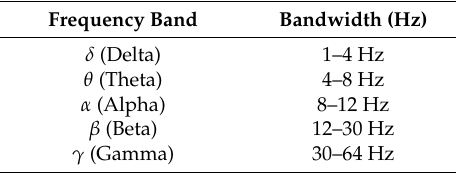
Table 3. Frequency band ranges of EEG signals.